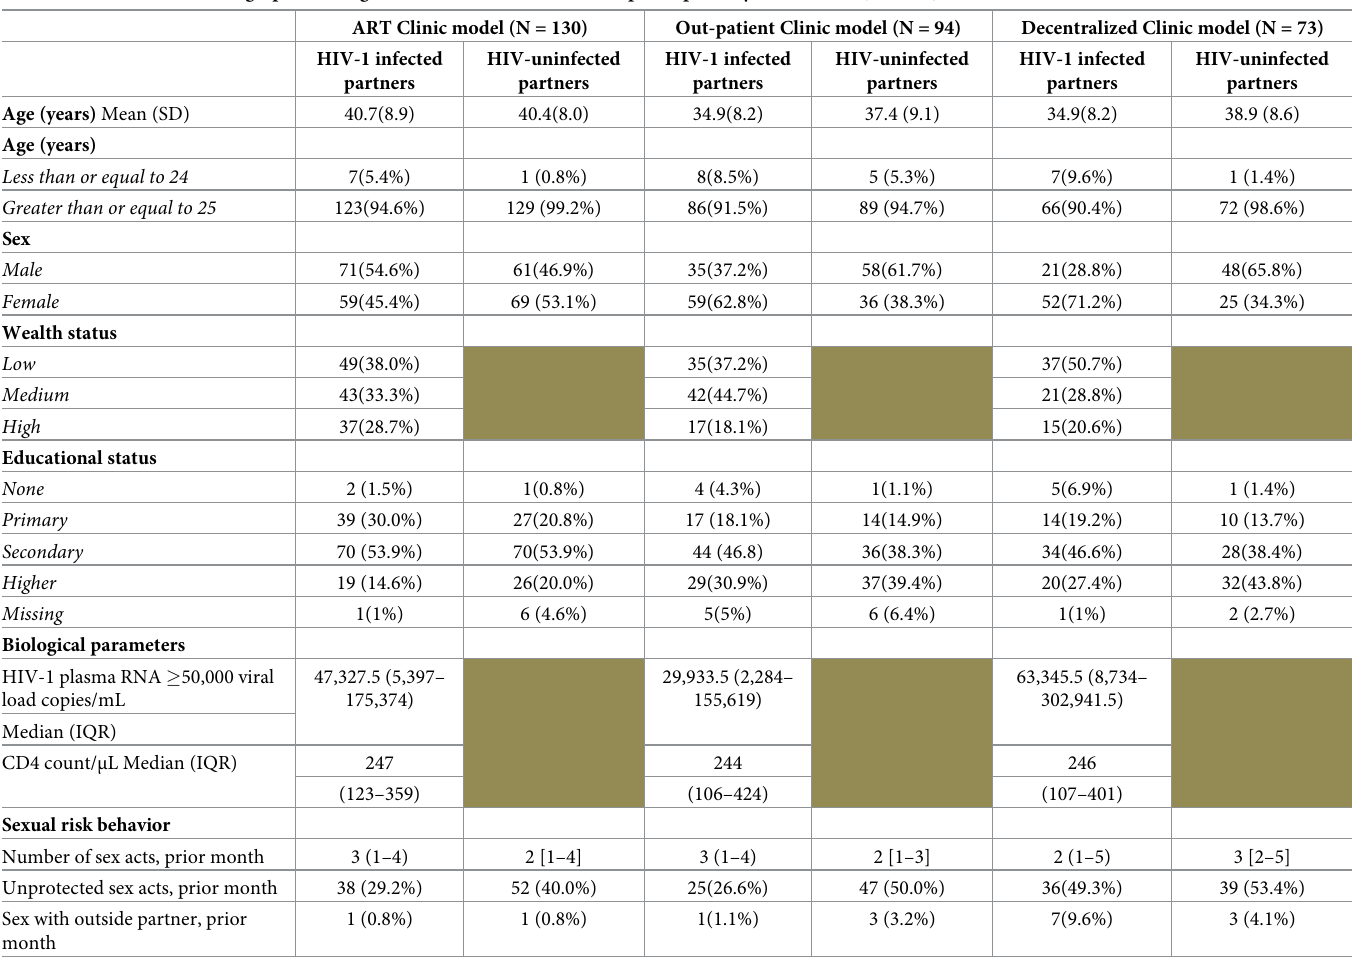
Table 1. Baseline socio-demographic, biological and sexual risk behavior of participants by PrEP model (N =